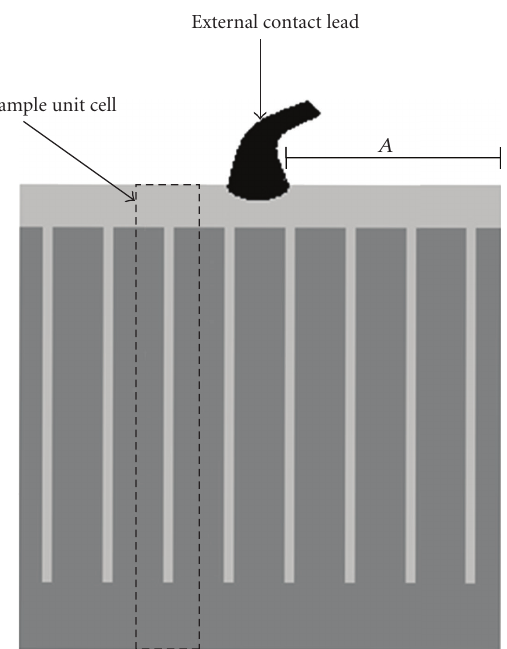
Figure 3: A sample unit cell within an interdigitated thin-film solar cell. The lighter grey areas correspond to emitter (busbar and finger) features, the dark grey areas correspond to BSF features, and the ex- ternal contact lead is shown in black. A is the distance from the edge of the cell to the external contact lead.